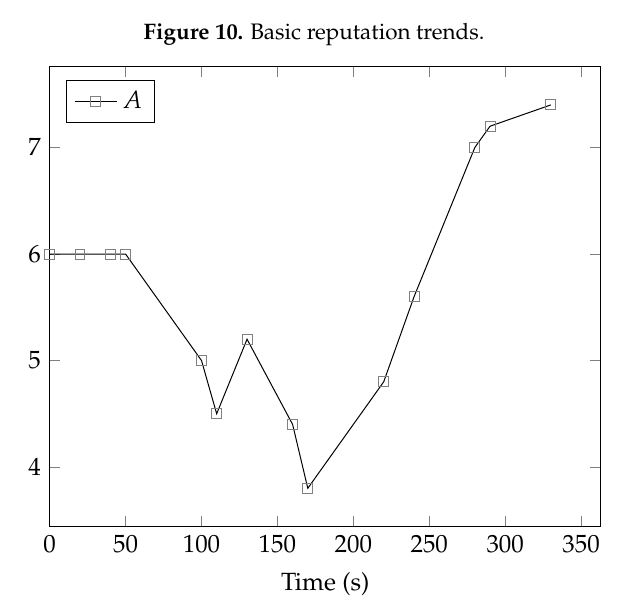
Figure 11. Composite reputation